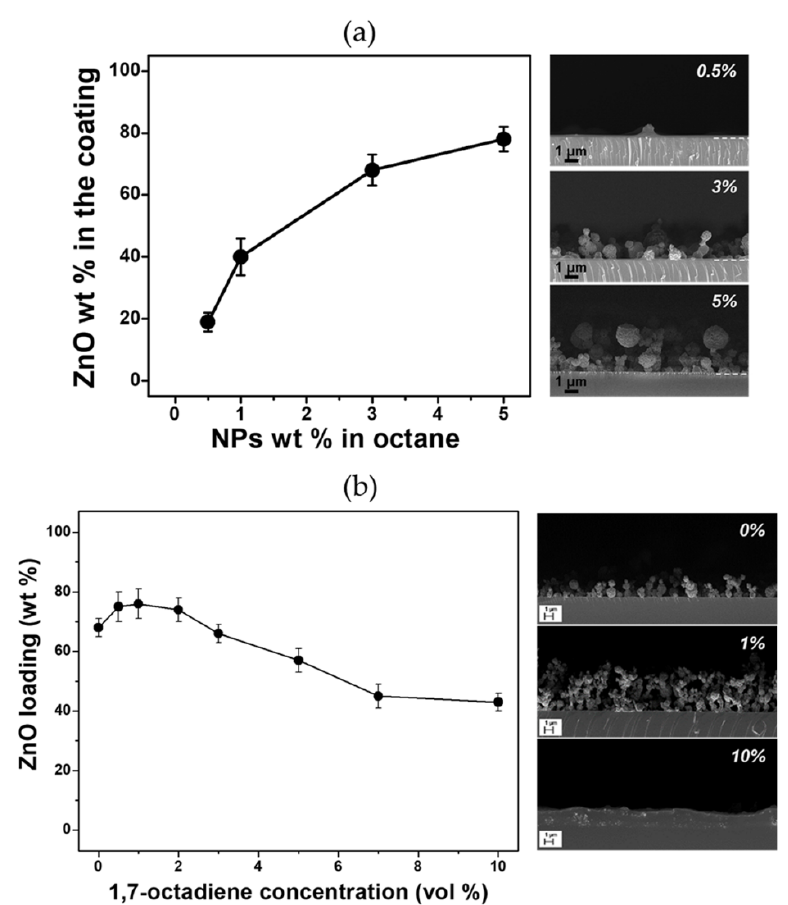
Figure 5. Effect of the composition of the starting NPs dispersion on the chemical composition and morphology of hydrocarbon polymer/ZnO NPs NC coatings deposited in a parallel-plate DBD fed with He and the aerosol of dispersion of oleate-capped ZnO NPs in hydrocarbon precursors. ( a ) ZnO loading and cross-sectional SEM images of NC coatings deposited from dispersions at different concentration of the oleate-capped ZnO NPs in n-octane (0–5 wt%). Reproduced with permission from [60]. ( b ) ZnO loading and cross-sectional SEM images of coatings deposited from dispersions characterized by different concentrations of 1,7-octadiene in the n-octane/1,7-octadiene solvent mixture. Reproduced with permission from [124].